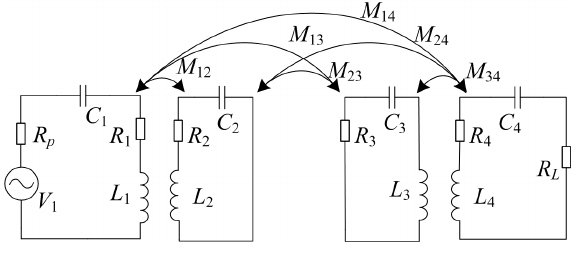
Figure 2. Equivalent circuit model of the WPT system.